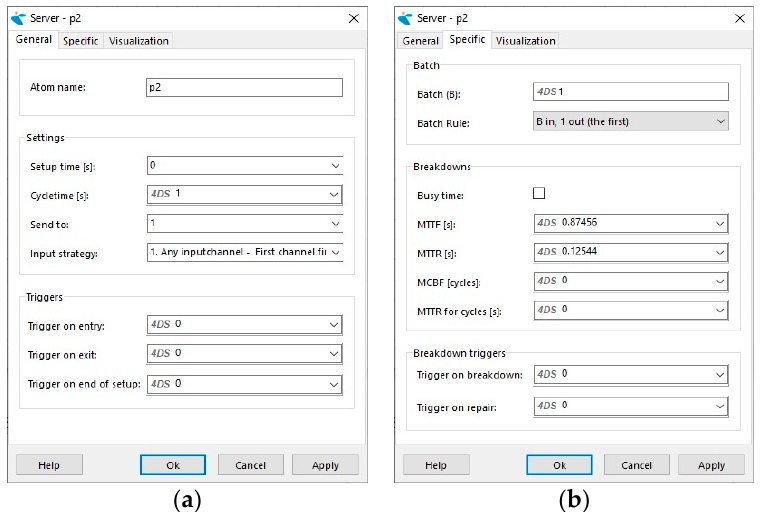
Figure 5. An example of assigning the ( a ) setup time of the machine and ( b ) breakdown time of the machine.